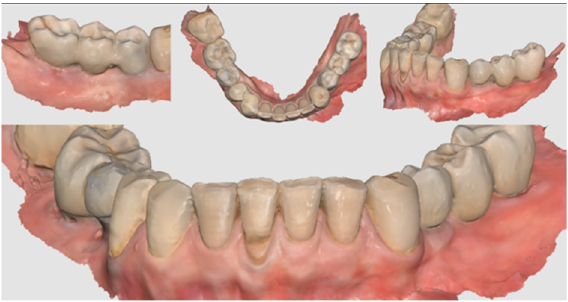
Figure 11. Scan taken after 18 months of prosthetic loading.